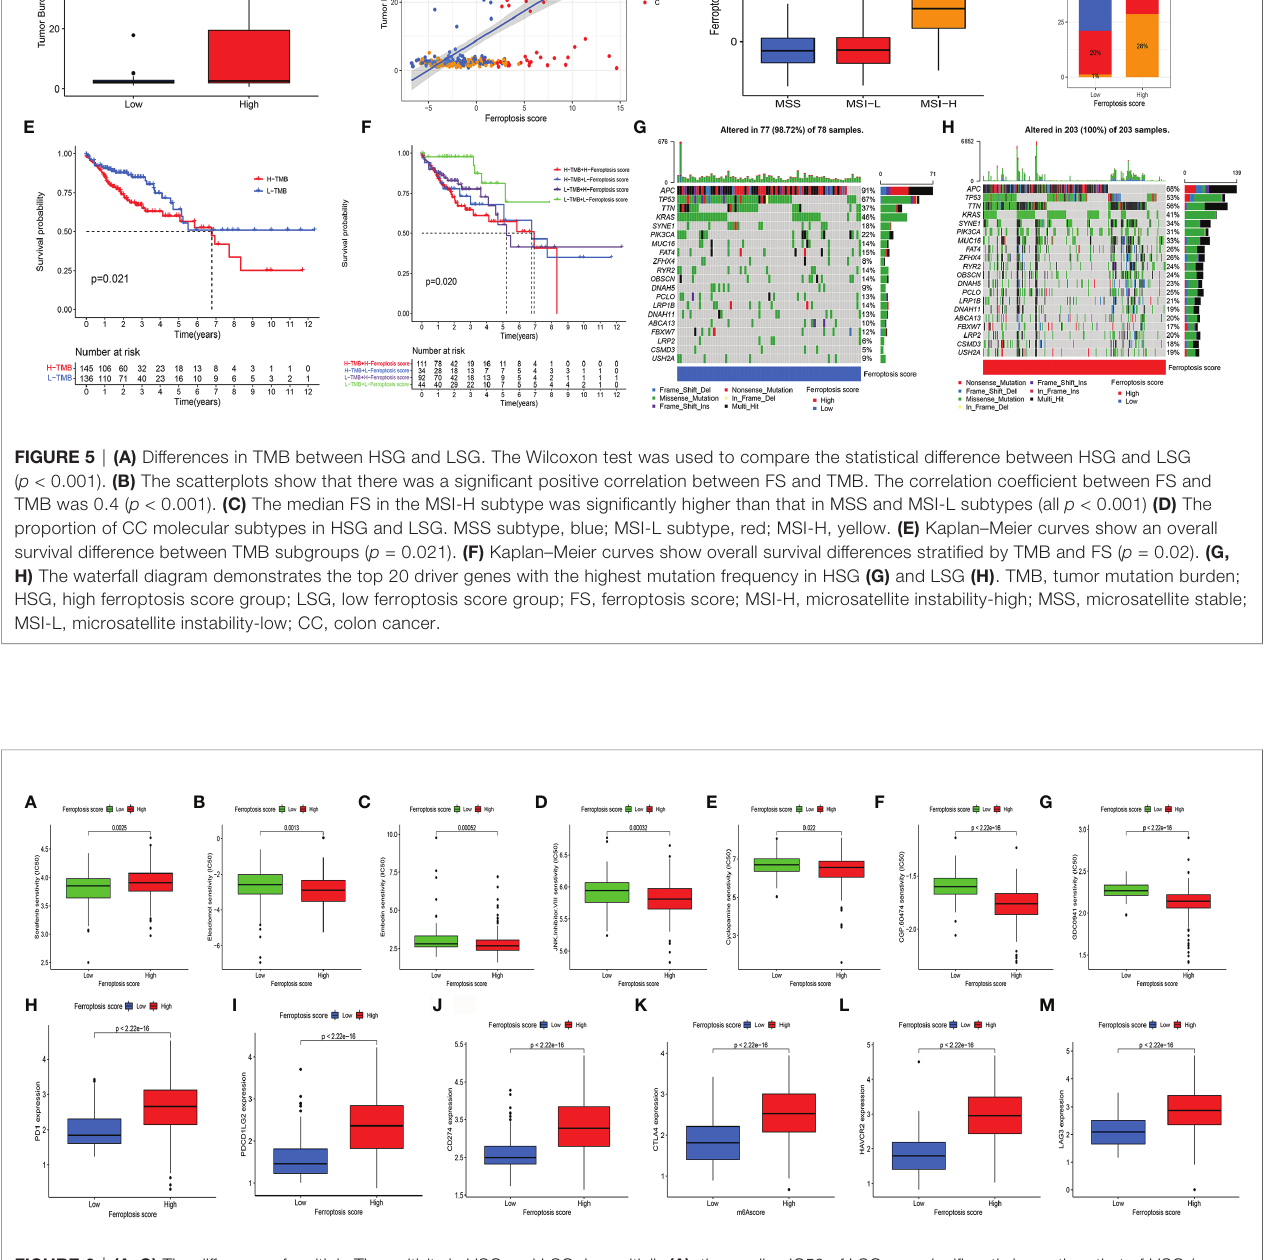
FIGURE 6 | (A – G) The difference of multiple TI sensitivity in HSG and LSG. In sunitinib (A) , the median IC50 of LSG was signi fi cantly lower than that of HSG ( p < 0.01). In elesclomol (B) , embelin (C) , JNK Inhibitor VIII (D) , cyclopamine (E) , CGP.60474 (F ), and GDC0941 (G) , HSG had a signi fi cantly lower median IC50 than LSG (all p < 0.05). (H – M) The difference of immune-suppressive checkpoint gene expressions between HSG and LSG. The expressions of PD1 (H) , PDCD1LG2 (I) , CD274 (J) , CTLA4 (K) , HAVCR2 (L) , and LAG3 (M) were higher in HSG than in LSG (all p < 0.001). The statistical difference was compared by the Wilcoxon test. TI, targeted inhibitor; HSG, high ferroptosis score group; LSG, low ferroptosis score